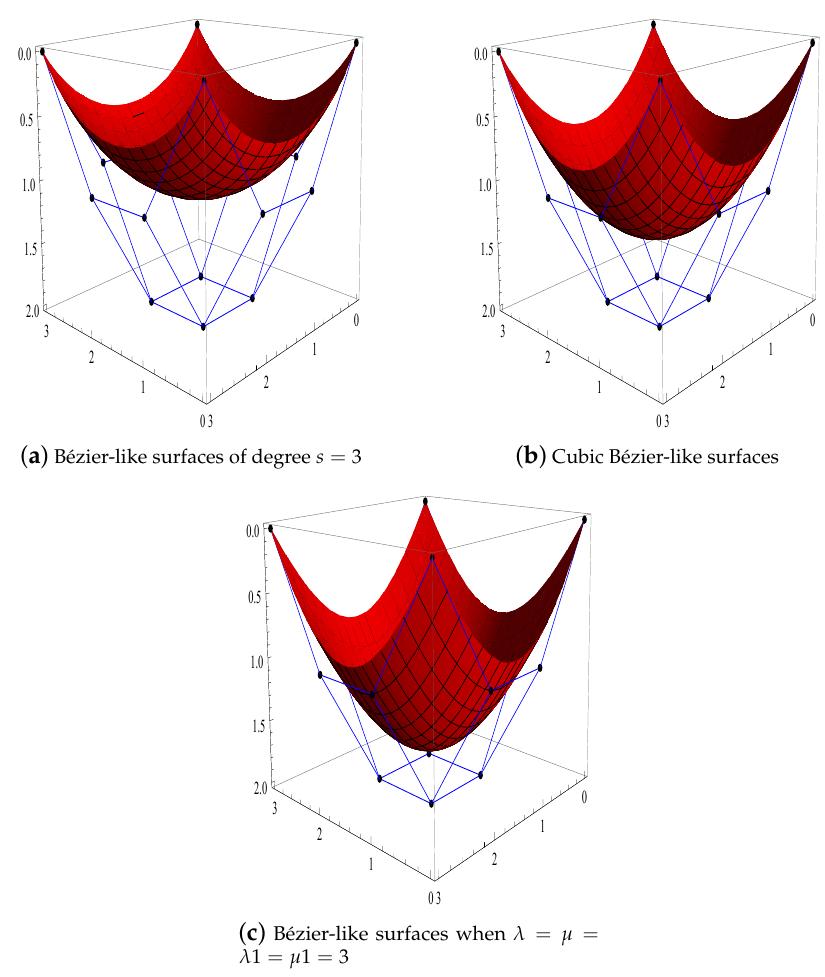
Figure 5. Three rectangular surfaces with the same control net but different shape